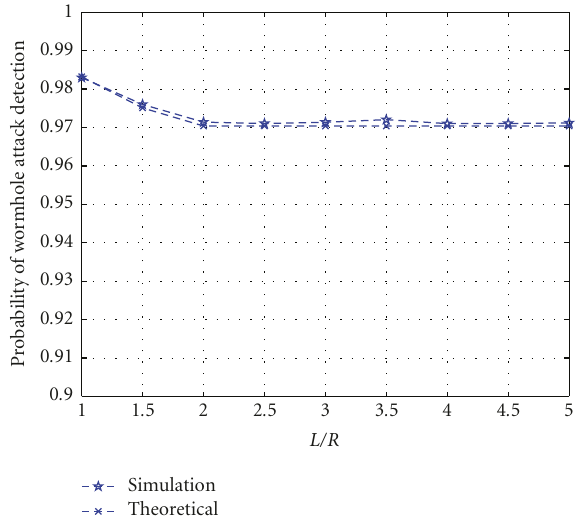
Figure 4: Probability of wormhole attack detection: Our scheme versus SeRLoc scheme.